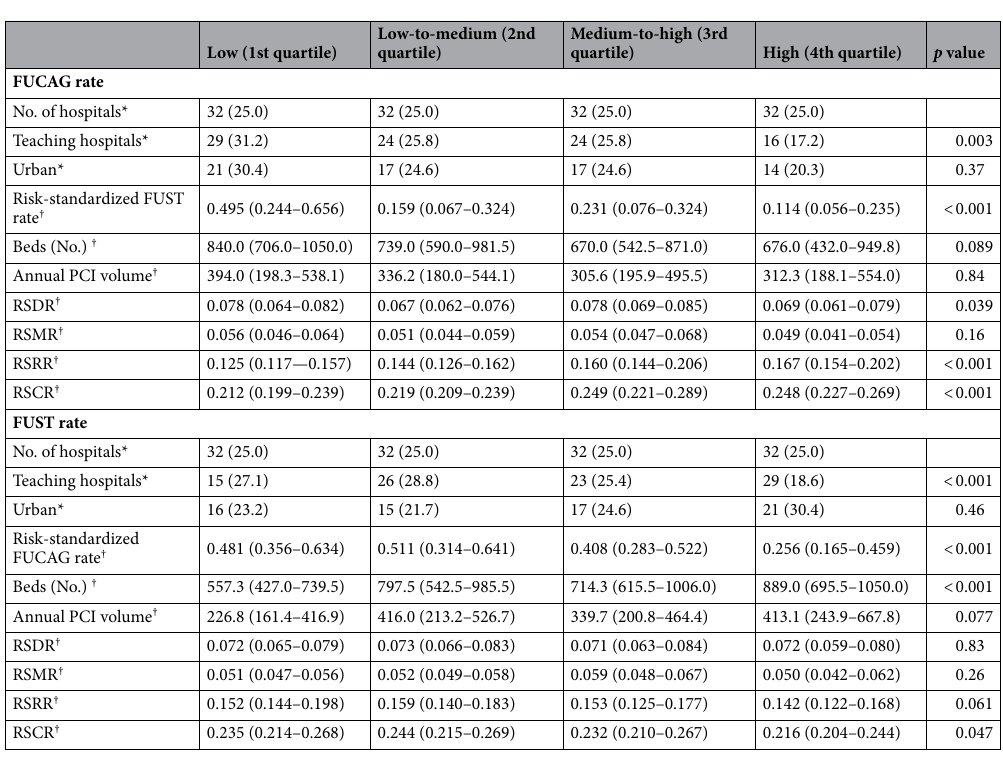
Table 2. Hospital characteristics according to follow-up strategy after percutaneous coronary intervention. *Data are expressed as number (percentage). † Data are expressed as median (interquartile range). FUCAG follow-up invasive coronary angiography, FUST follow-up stress testing, PCI percutaneous coronary intervention, RSCR risk-standardized the composite outcome (a composite of all-cause death, myocardial infarction, or repeat revascularization) rate, RSDR risk-standardized death rate, RSMR risk-standardized myocardial infarction rate, RSRR risk-standardized repeat revascularization